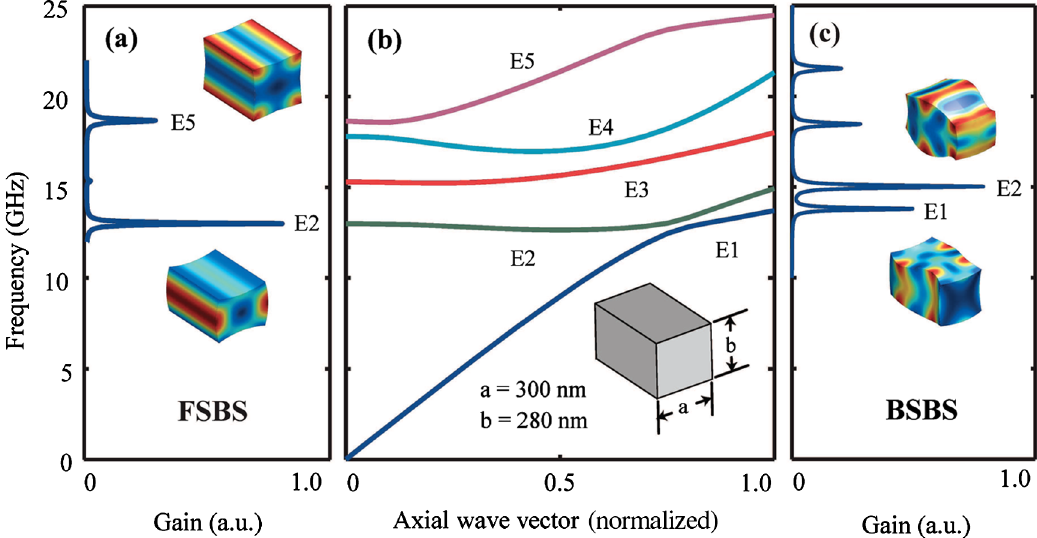
FIG. 2. Computed SBS gain shown in arbitrary units (a.u.) for (a) FSBS and (c) BSBS processes, for comparison with the computed phonon dispersion of the lowest-order symmetric phonon modes (labeled E1–E5) seen in (b). The FSBS and BSBS resonances match for wavelength (cid:2) ¼ 1550 nms . Colored insets well with computed dispersion of (b). In (b), the wave vector is normalized by K ¼ 2 k p of (a) show the displacement amplitudes and shape deformation of the dominant E2 and E5 phonons about K ¼ 0 excited through in the BSBS case. High (low) displacement regions are shaded red FSBS, while those of (c) show the E1 and E2 modes at K ¼ 2 k p (blue). Calculations assume silicon waveguide dimensions of a ¼ 300 nm and b ¼ 280 nm and wavelength (cid:2) ¼ 1550 nms . Note, elastic modes which do not contribute to SBS have been omitted from the dispersion plot in (b). For clarity, the computed elastic modes seen in (b) were restricted to those with reflection symmetries about the x - z and y - z mirror planes centered on the waveguide core. However, the frequency dependent elastic-wave models used to compute SBS gain in (a) and (c) do not limit the number of modes by use of symmetry. Hence, SBS gain shown in (a) and (c) includes the contribution to photon-phonon coupling arising from all acoustic modes in the